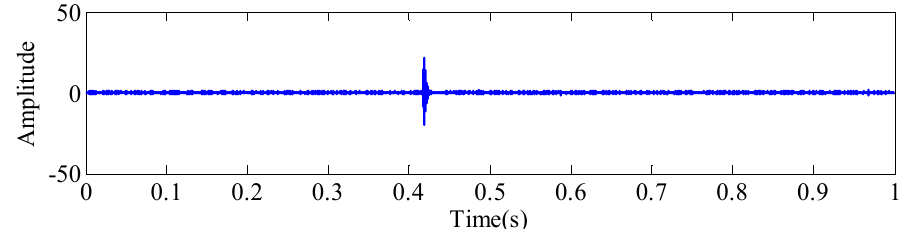
Figure 10. Signal segment with random value at 7 seconds to construct singular value decomposition noise reduction signal of Hankel matrix.